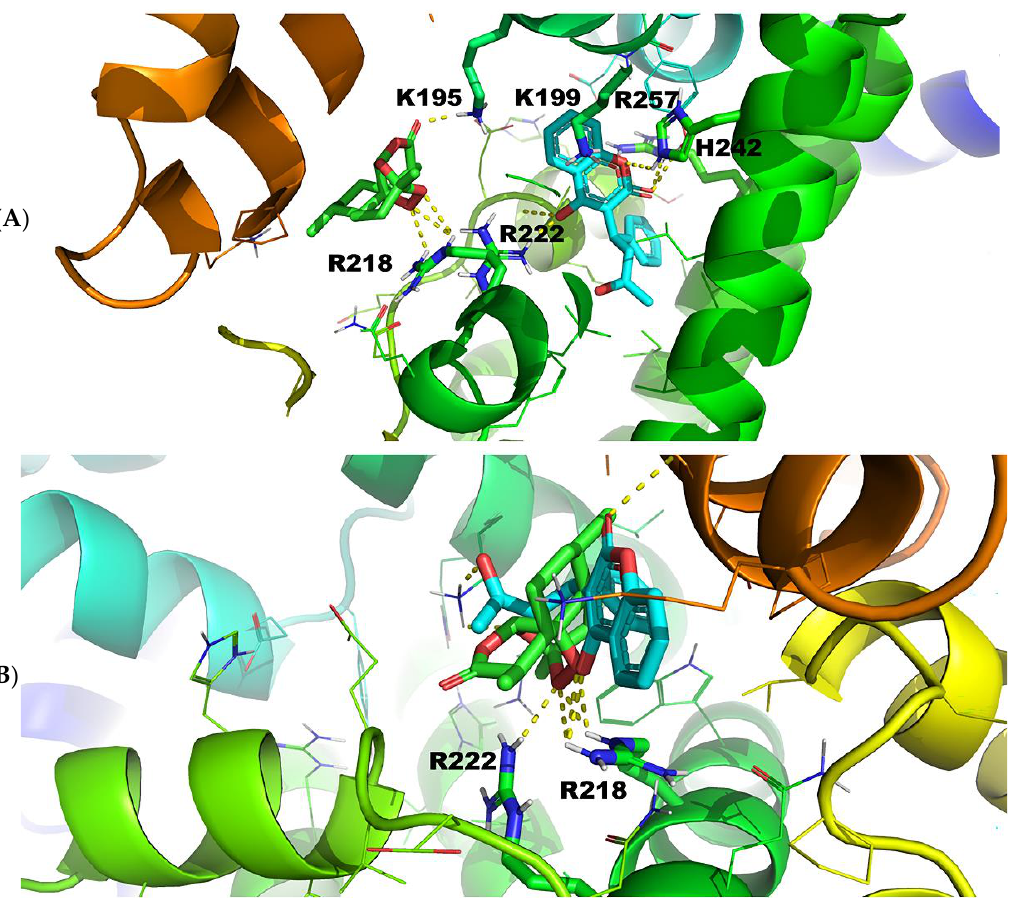
Figure 9. ( A ) Pose number 2 of warfarin and artemisinin for binding site FA7 of HSA (1BM0.pdb). ( B ) Superimposed pose number 2 of ( A ).